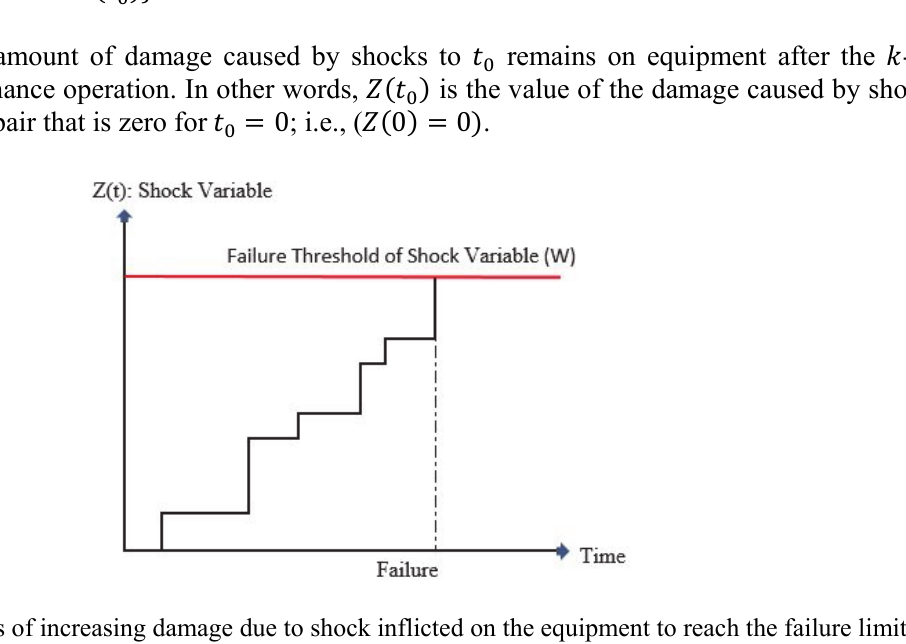
Fig. 2 . The process of increasing damage due to shock inflicted on the equipment to reach the failure limit